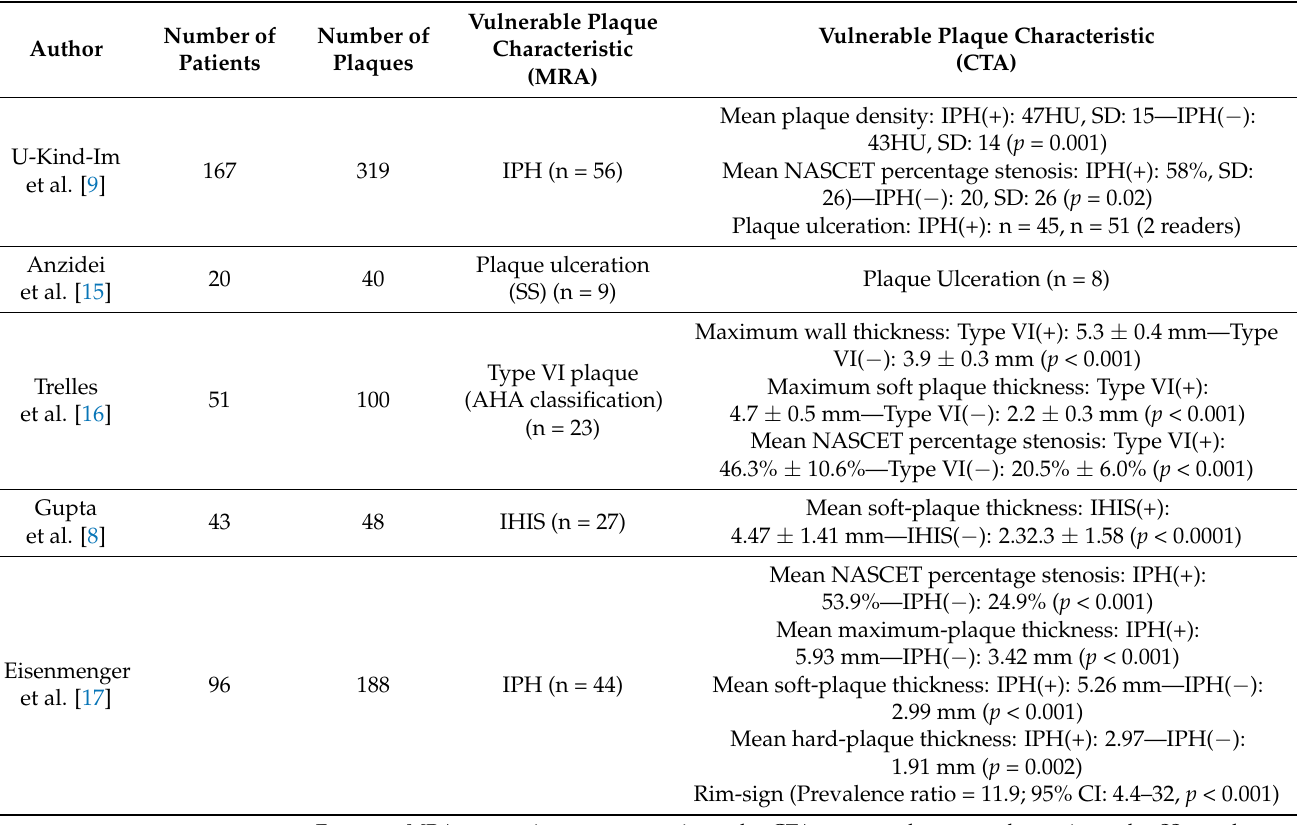
Table 4. Association between vulnerable carotid plaque MRA and CTA characteristics as reported in the included studies.